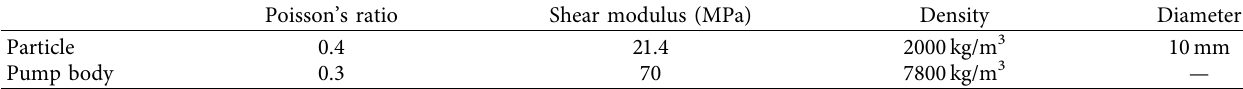
Table 2: Properties of particle and pump body.